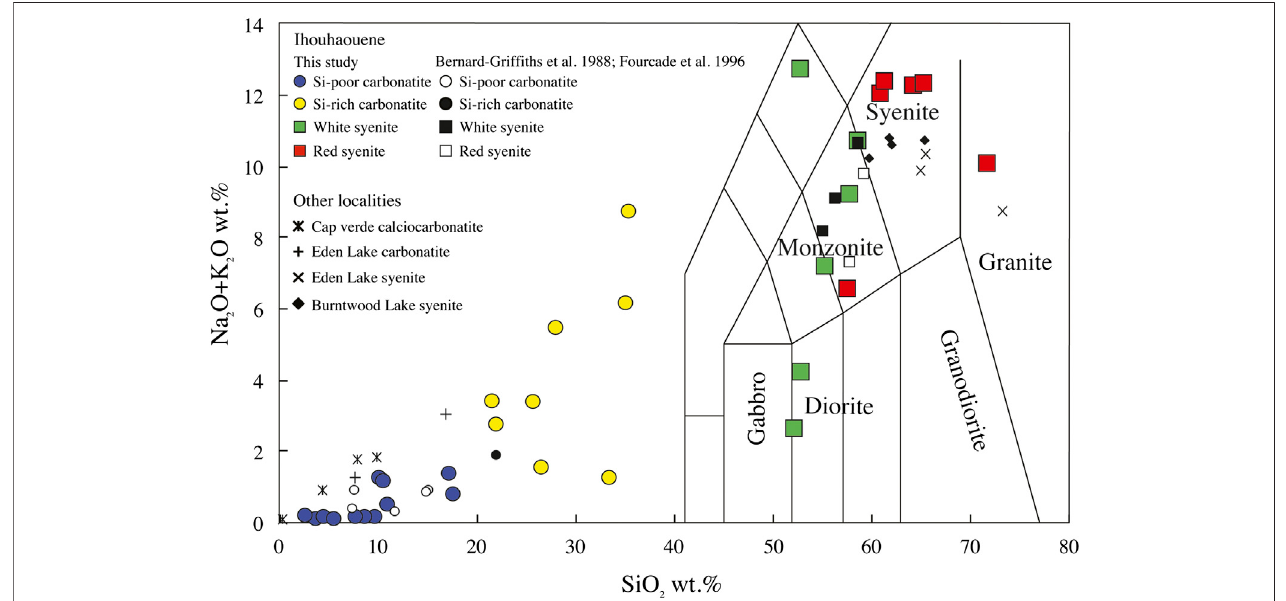
FIGURE 4 | Ihouhaouene carbonatites and associated syenites in total alkali – silica (TAS) diagram (after Le Maitre et al., 1989). Cap verde carbonatites (Weinderdorfer et al., 2016), Eden Lake carbonatites and syenites (Chakhmouradian et al., 2008), and Burntwood Lake syenites (Martins et al., 2011) are shown.